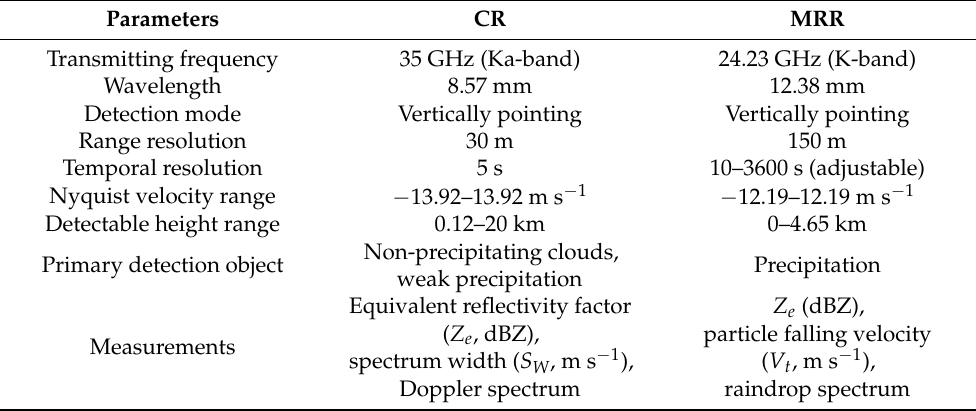
Table 1. The main specifications of CR and